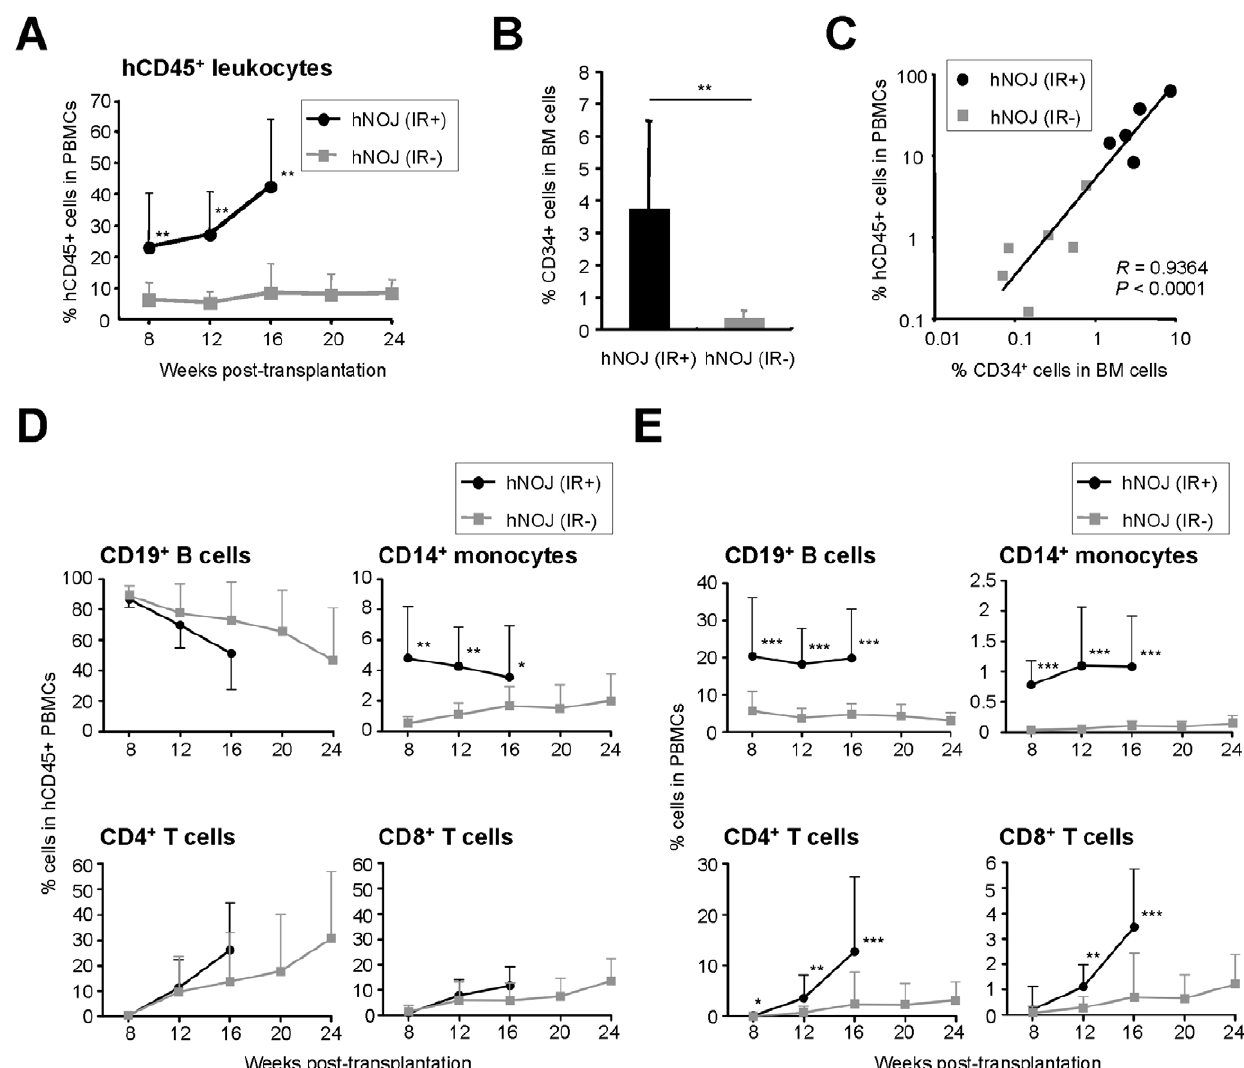
Figure 2. Development of human hematopoietic cells in hNOJ mice. (A) Changes in the percentage of human CD45 + (hCD45 + ) cells within the PBMC population from hNOJ (IR + ) and hNOJ (IR 2 ) mice ( n =22 and n =13, respectively). Data are expressed as the mean 6 SD. Significant differences ( ** P , 0.01) were determined by the Mann-Whitney U test. (B) Percentage of human CD34 + cells within the BM cells isolated from hNOJ (IR + ) and hNOJ (IR 2 ) mice ( n =5 and 6, respectively) at 8 wk post-transplantation. Data are expressed as the mean 6 SD. Significant differences ( ** P , 0.01) were determined by the Mann-Whitney U test. (C) Association between the percentage of hCD45 + cells within the PBMC population and that of CD34 + cells within the BM cells of hNOJ (IR + ) and hNOJ (IR 2 ) mice at 8 wk post-transplantation (11 plots from five hNOJ (IR + ) and six hNOJ (IR 2 ) mice). Spearman’s rank correlation coefficient was used for statistical analysis. (D, E) Changes in the percentage of human CD19 + B cells, CD14 + monocytes, CD4 + T cells (CD3 + CD4 + CD8 2 cells), and CD8 + T cells (CD3 + CD4 2 CD8 + cells) within the peripheral blood hCD45 + cell population (D) or total PBMC populstion (E) from hNOJ (IR + ) and hNOJ (IR 2 ) mice ( n =22 and n =13, respectively). Data are expressed as the mean 6 SD. Significant differences ( * P , 0.05, ** P , 0.01, *** P , 0.001) were determined by the Mann-Whitney U